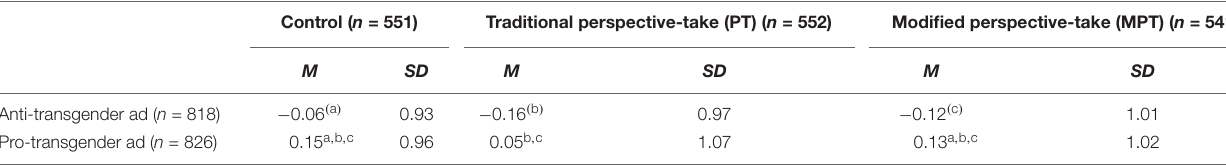
TABLE 3 | Transgender rights scale, means and standard deviations by treatment group (Study 2).